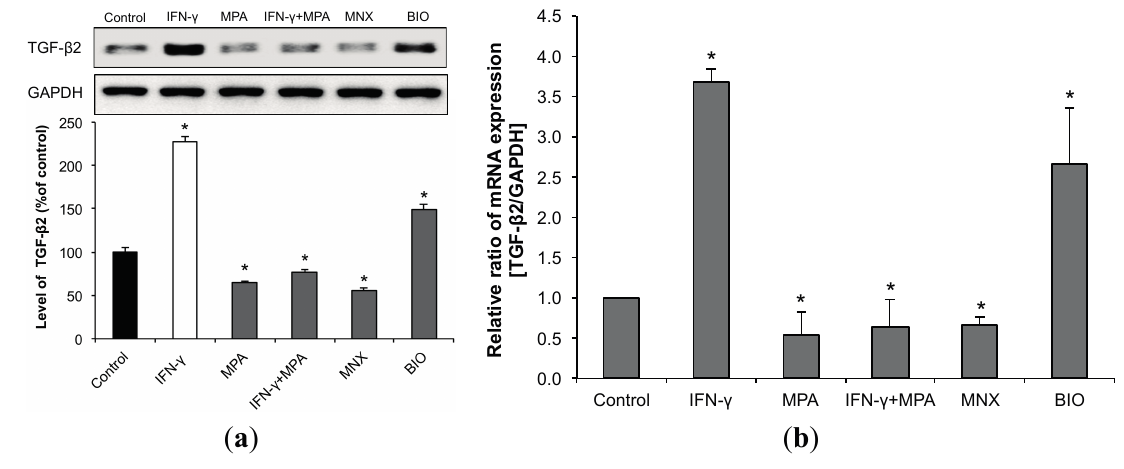
Figure 5. MPA reduces expression of the catagen-inducing cytokine TGF- β 2 in hDPCs even following treatment with IFN- γ . hDPCs were treated with 100 ng/mL of IFN- γ , 100 nM of MPA, or with both IFN- γ and MPA for 48 h. ( a ) The protein level of TGF- β 2 was examined by Western blot using an anti-TGF- β 2 antibody, and its relative level was normalized to that of GAPDH; ( b ) TGF- β 2 mRNA expression was measured by real-time RT-PCR using its specific sense and antisense primers, as described in “Materials and Methods”. The relative expression of each mRNA was normalized to that of GAPDH. MNX and BIO served as controls for TGF- β 2 expression. Results were expressed as mean ± SD from three independent experiments. Statistically significant differences were determined by ANOVA ( * p < 0.05)